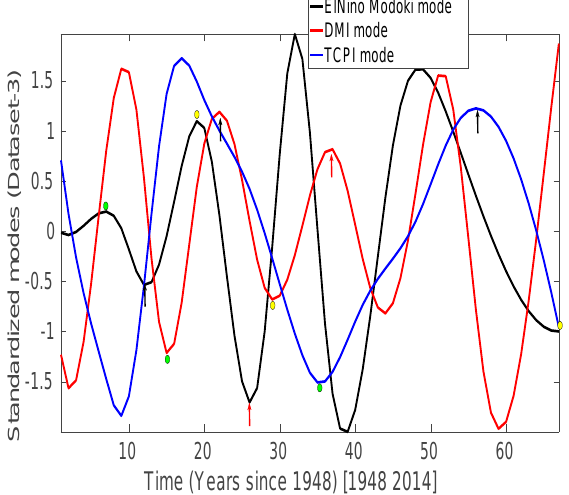
Figure 11. Comparison of the third modes of TCPI, DMI and El Niño Modoki index using Dataset-2. A peak in the El Niño Modoki mode appears to drive the dip in the DMI (or IOD). A valley in the DMI, in turn, drives the TCPI dip in the North Indian Ocean. Climate 2019 , 7 , x FOR PEER REVIEW